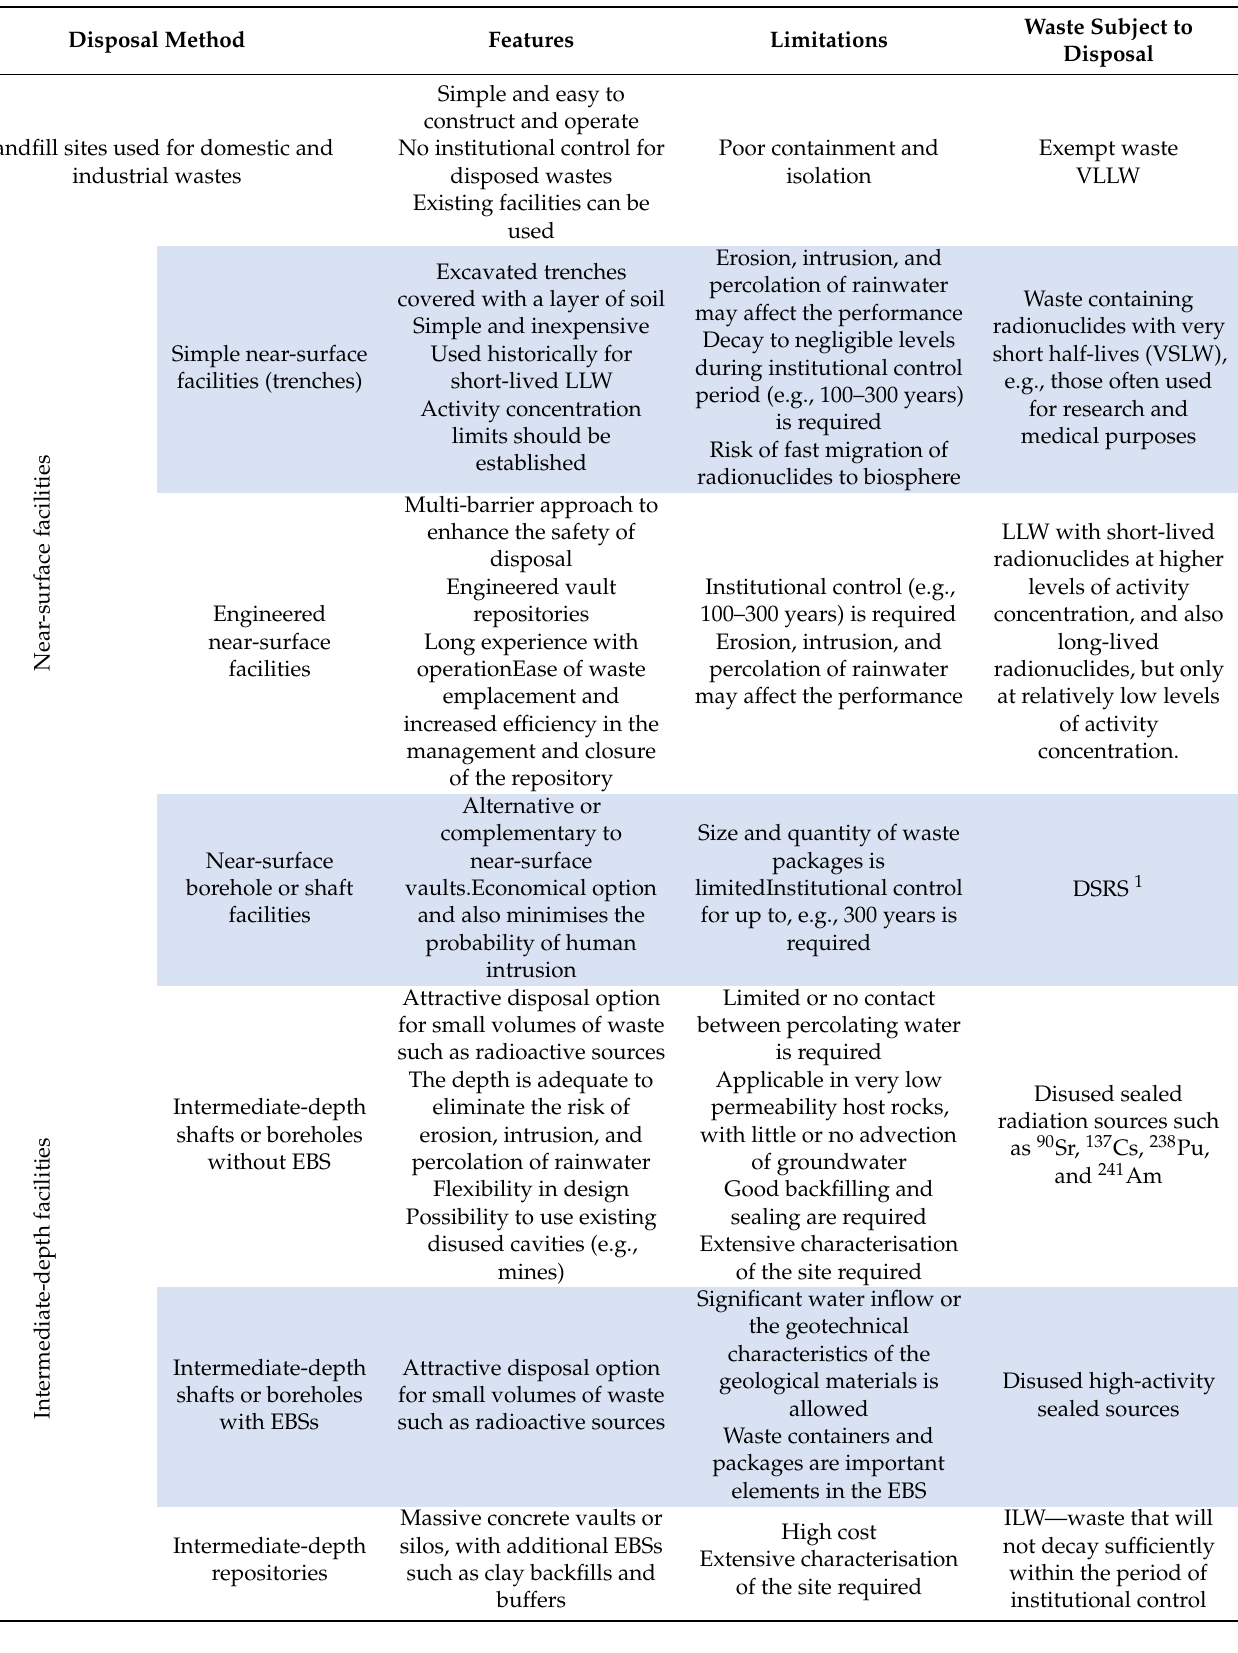
Table 7. Nuclear waste disposal options. Reproduced with permission of the IAEA from